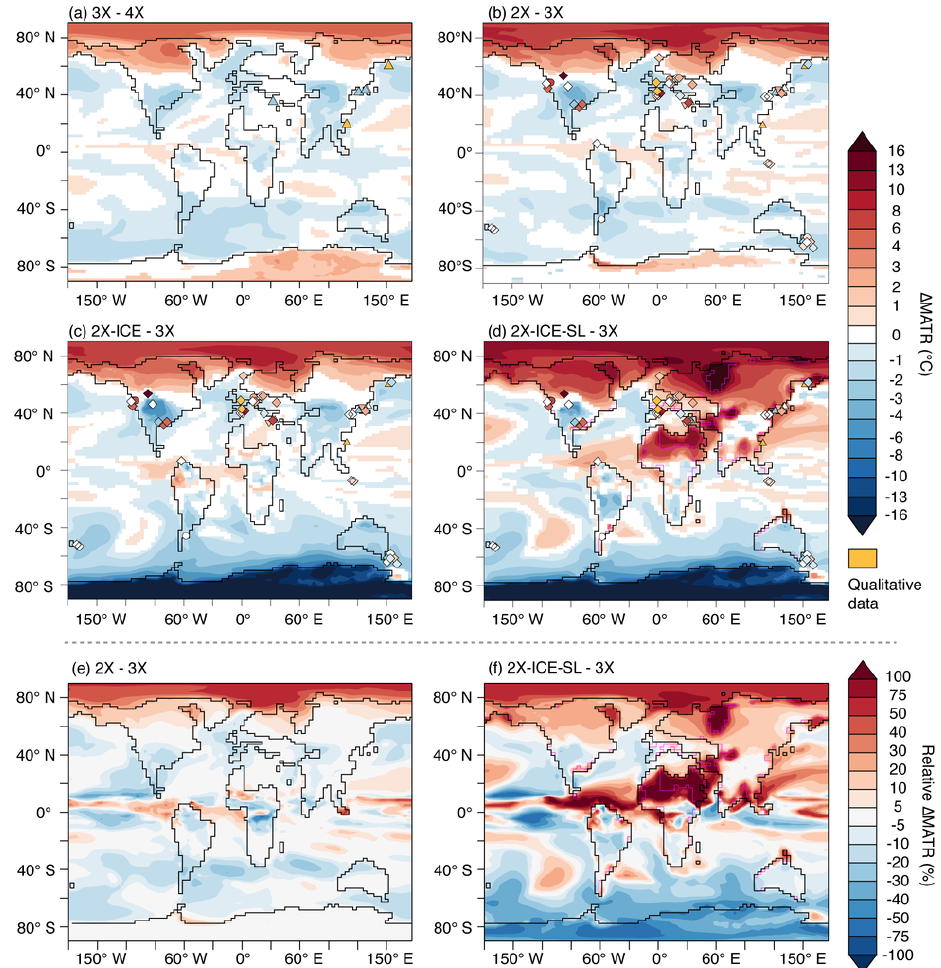
Figure 4. Changes in mean annual temperature range, (cid:49) MATR ( ◦ C). Shadings are model differences calculated with a Student t test over the last 100 years of comparative simulations (95% confidence); white areas indicate no significant (cid:49) MATR. Panels (e) and (f) indicate relative (cid:49) MATR (in %) for 2 X –3 X and 2 X -ICE-SL–3 X , respectively. Symbols correspond to (cid:49) MATR from proxy data for different time steps: Priabonian–Lutetian (triangles); Rupelian–Lutetian (inverted triangles); Rupelian–Bartonian (circles); Rupelian–Priabonian (diamonds). Or- ange symbols indicate qualitative values describing a temperature seasonality increase. In the case of proxies reconstructing a range of equally probable values (e.g., the Coexistence Approach), the values shown are mean values. References are displayed in Fig. 8 and available in the data compilation provided in Table S1 in the